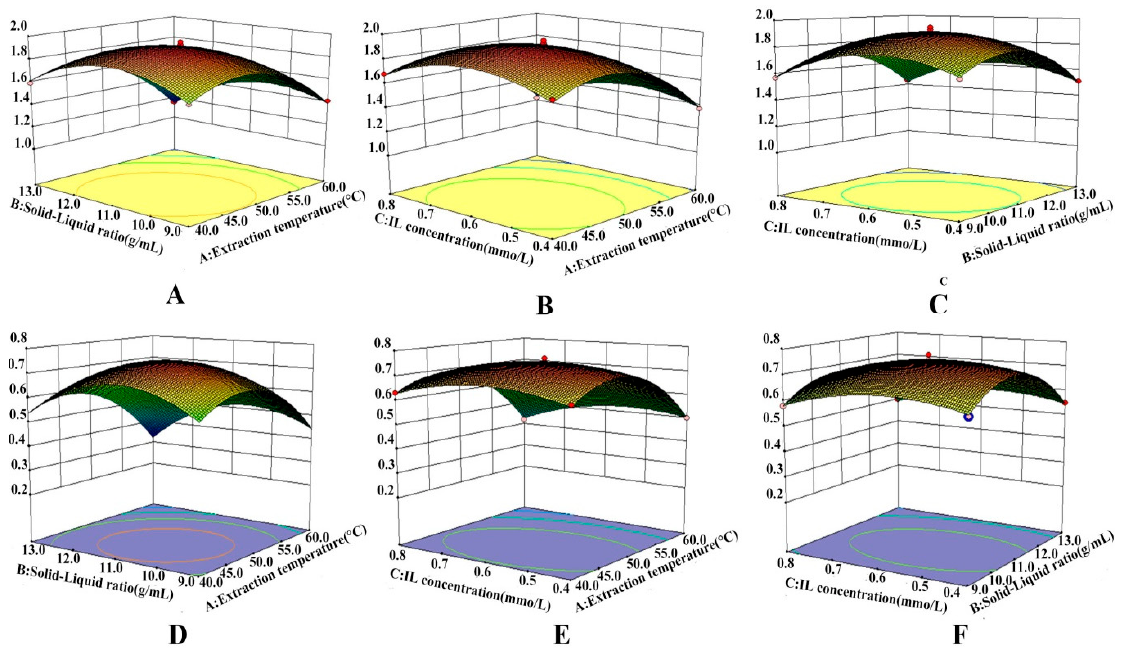
Figure 5. Response surface plots showing interaction effects of solid–liquid ratio and extraction temperature ( A ); extraction temperature and IL concentration ( B ); solid–liquid ratio and IL concentration ( C ) on AME yield and solid–liquid ratio and extraction temperature ( D ); extraction temperature and IL concentration ( E ); solid–liquid ratio and IL concentration ( F ) on HIN yield.